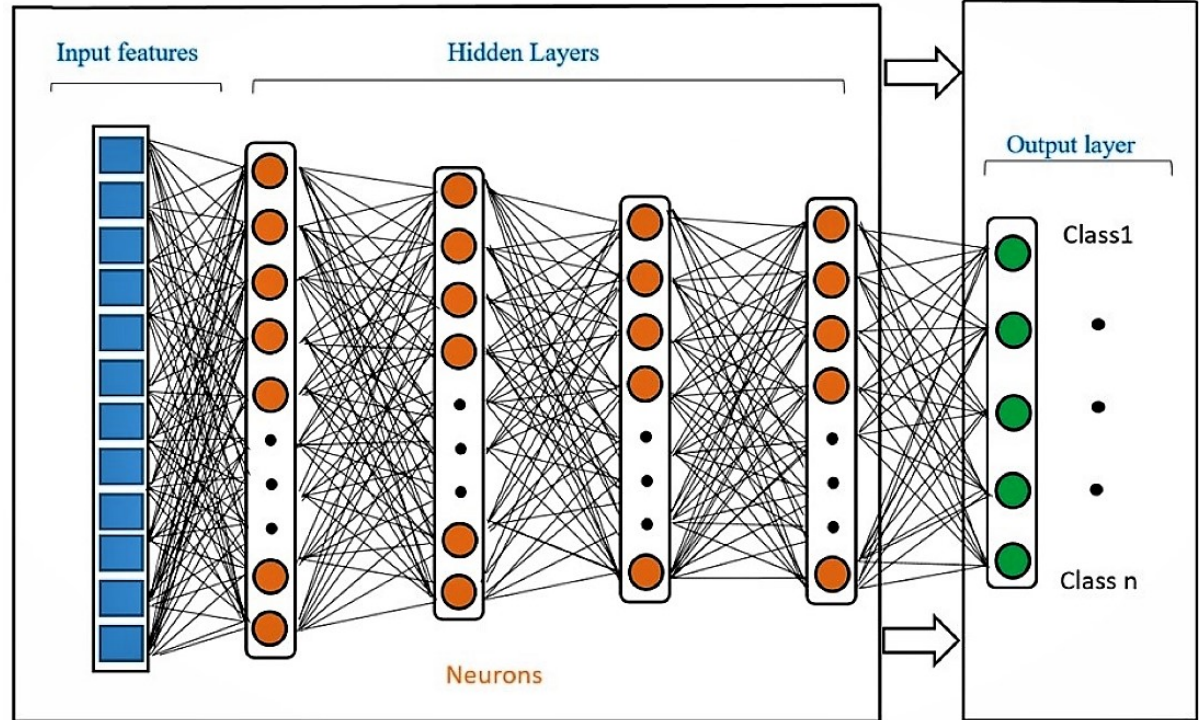
Figure 1. General structure of feedforward multilayer neural